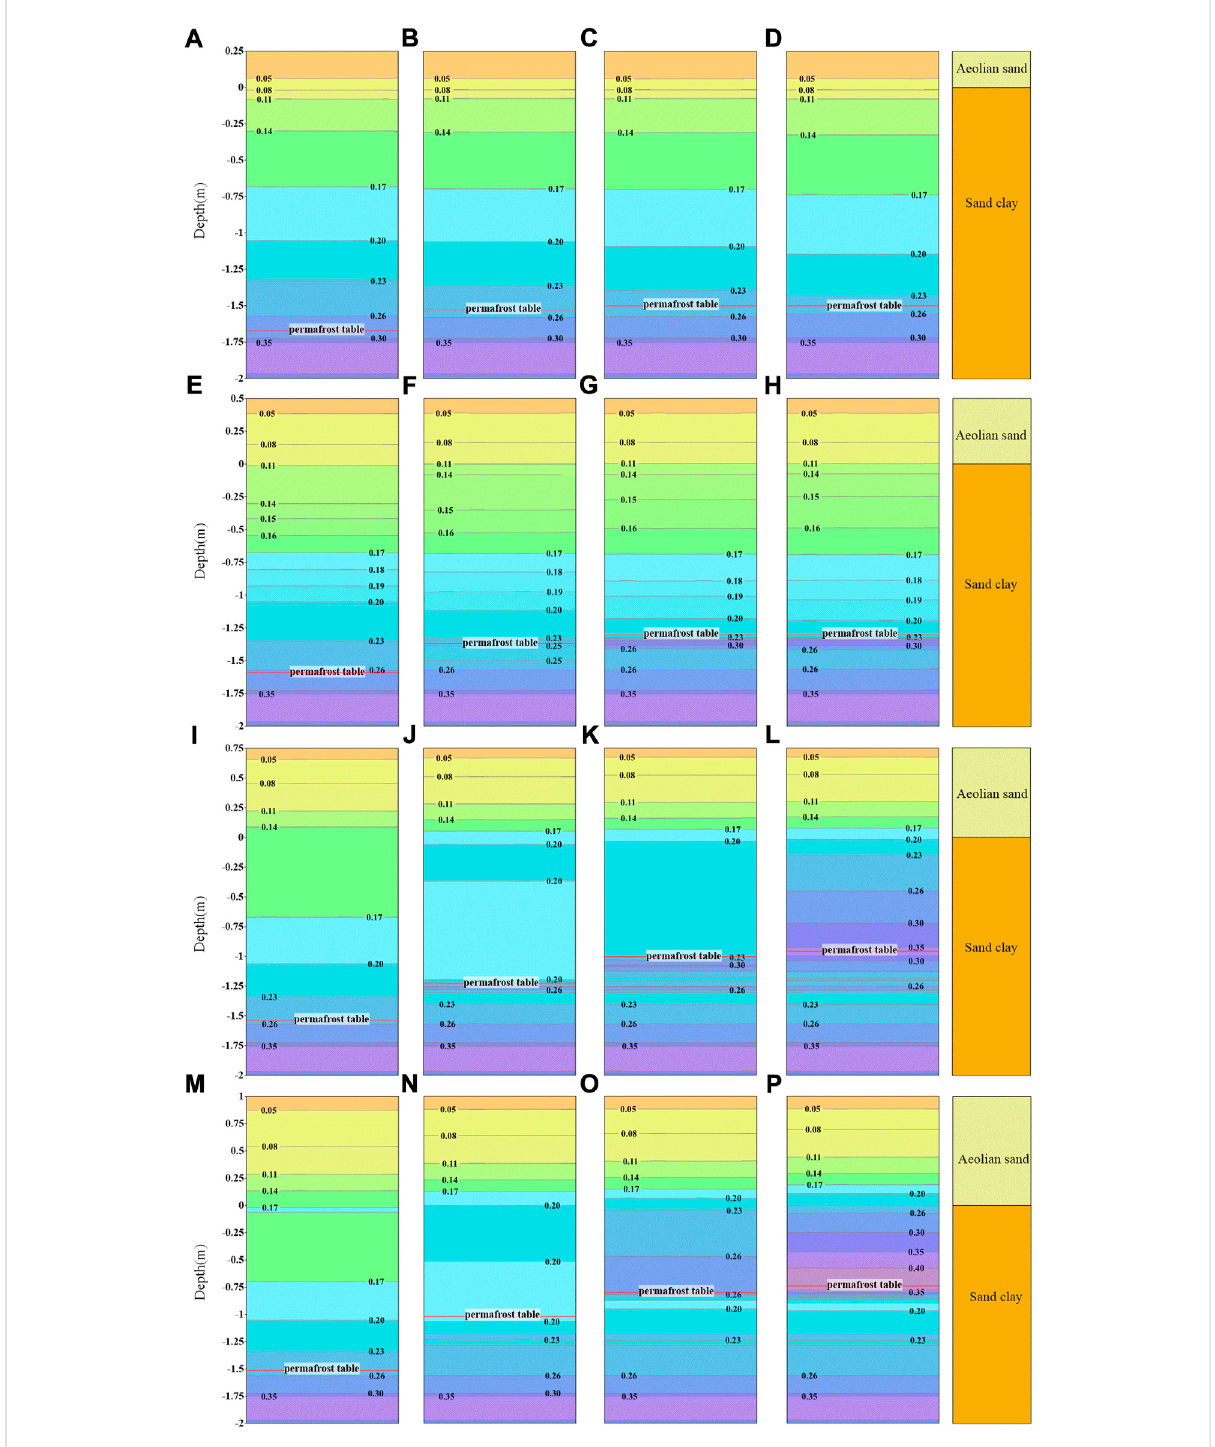
FIGURE 9 The water content distributions of stratum and sand layer with thickness of 0.25 m in the (A) fi rst year (B) fi fth year (C) 10th year (D) 20th year, 0.50 m in the (E) fi rst year (F) fi fth year (G) 10th year (H) 20th year, 0.75 m in the (I) fi rst year (J) fi fth year (K) 10th year (L) 20th year, and 1.00 m